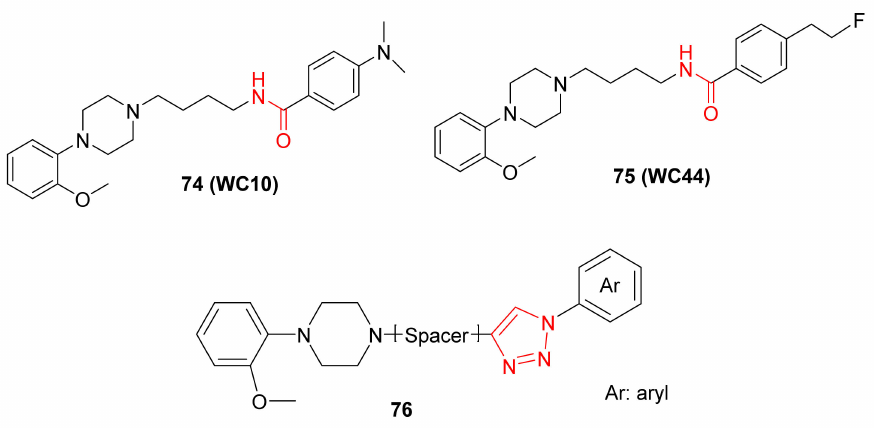
Figure 26. Structure of the compounds WC 10 and WC 44, and their triazole